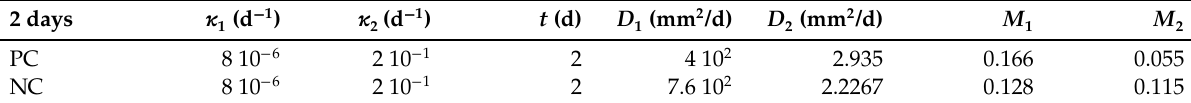
Table 6: Parameter values for chloride concentrations of pure concrete under PD after 2 days.